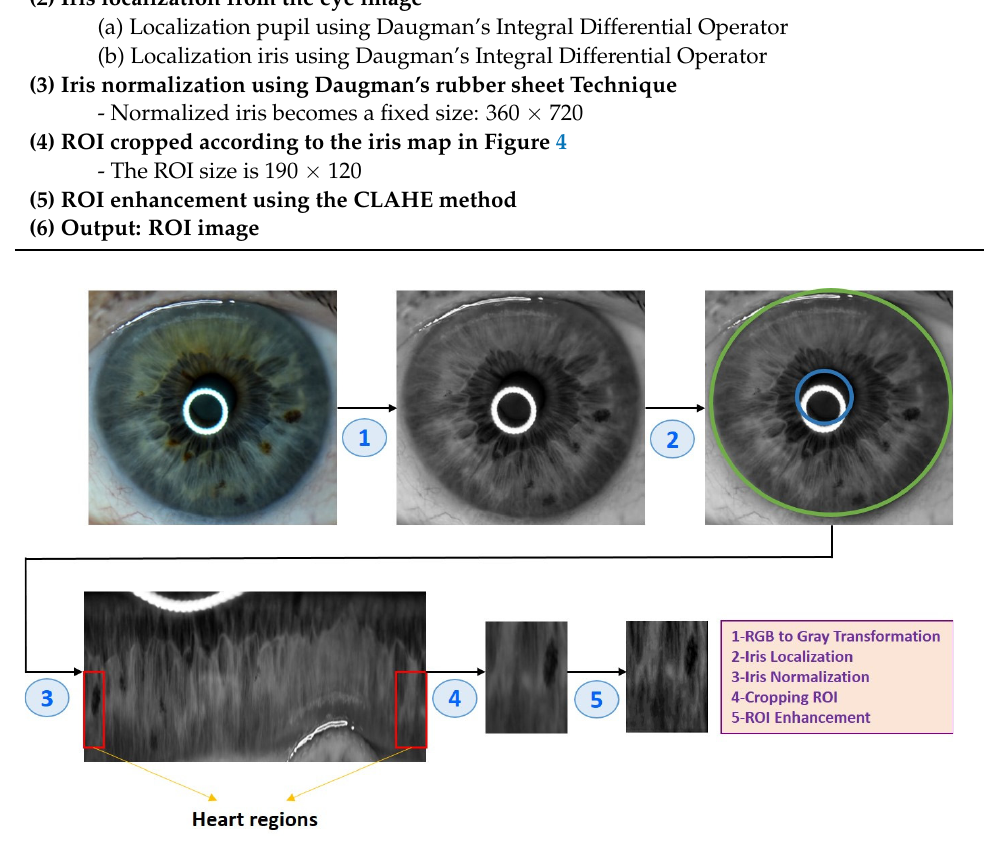
Figure 4. An example of the pre-processing process used in the study.